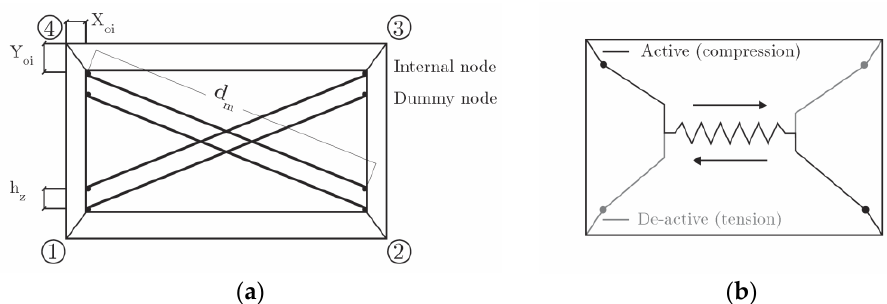
Figure 6. Crisafulli model for ( a ) compression/tension struts and ( b ) shear struts (adapted from Ref. [261]).